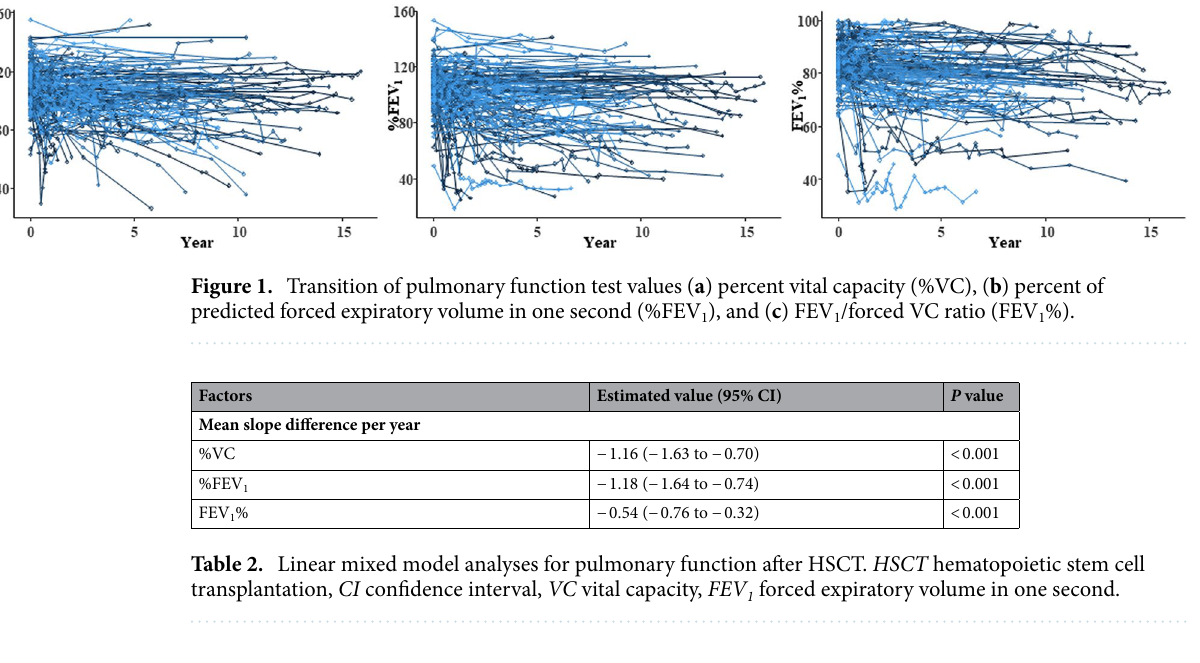
Table 2. Linear mixed model analyses for pulmonary function after HSCT. HSCT hematopoietic stem cell transplantation, CI confidence interval, VC vital capacity, FEV 1 forced expiratory volume in one second.